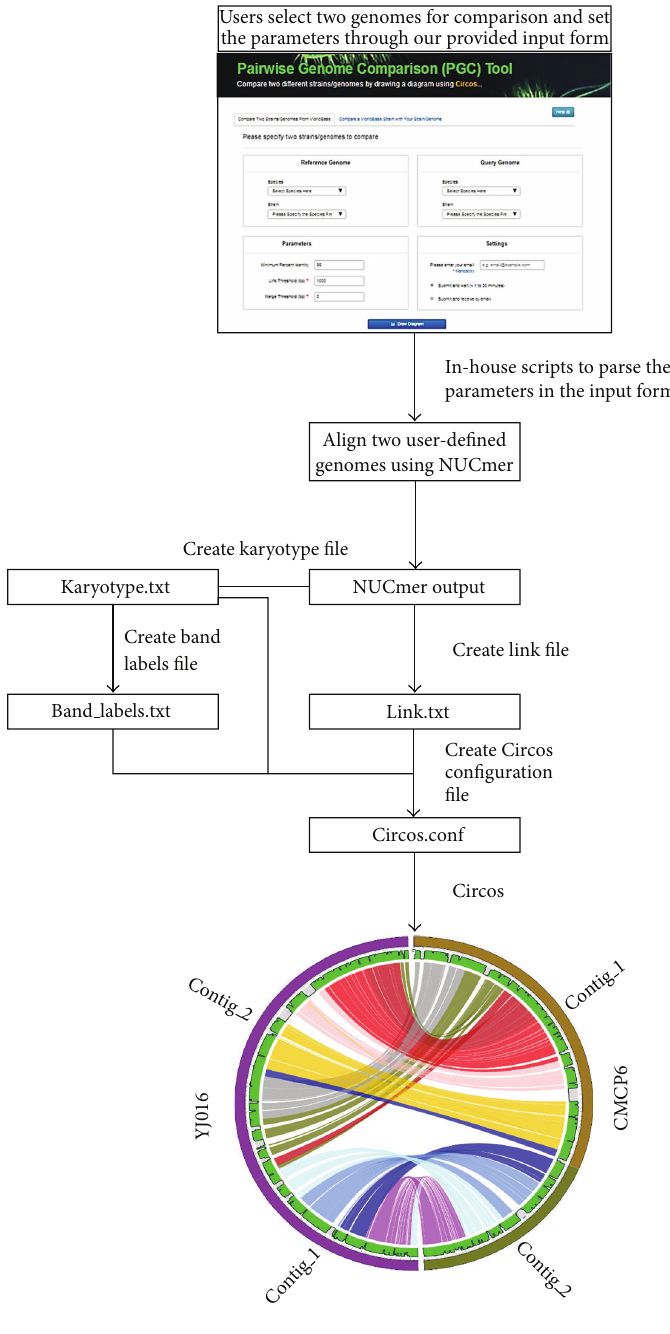
Figure 1: A workflow of the PGC tool. Through an input web interface on VibrioBase, users can choose two genomes of interest (reference versus query genomes) in VibrioBase and parameters for comparison. Three available useful parameters/thresholds which are the minimum percent identity, merge threshold, and link threshold. The minimum percent identity parameter will display aligned genomic regions (represented by colored links) once the sequence identity is higher than the user-defined cut-off. Similar to the merge threshold, this threshold will merge two links if the distance between the two regions is lower than the user-defined cut-off. The link threshold ignores links in the diagram if their widths are lower than the user-defined cut-off. Once the job is submitted to our server, PGC pipeline parses this information and starts the genome alignment with NUCmer. A series of in-house Perl and Python scripts are used to parse the NUCmer output and generate different text files: (1) Karyotype.txt stores information about the contigs and their colors used in Circos; (2) Links.txt stores information about the aligned genomic regions; (3) Band labels.txt keeps the names of each contigs/chromosome. The Circos.conf configuration file will be created using the information in the above four files, which is needed for displaying the two aligned genomes with